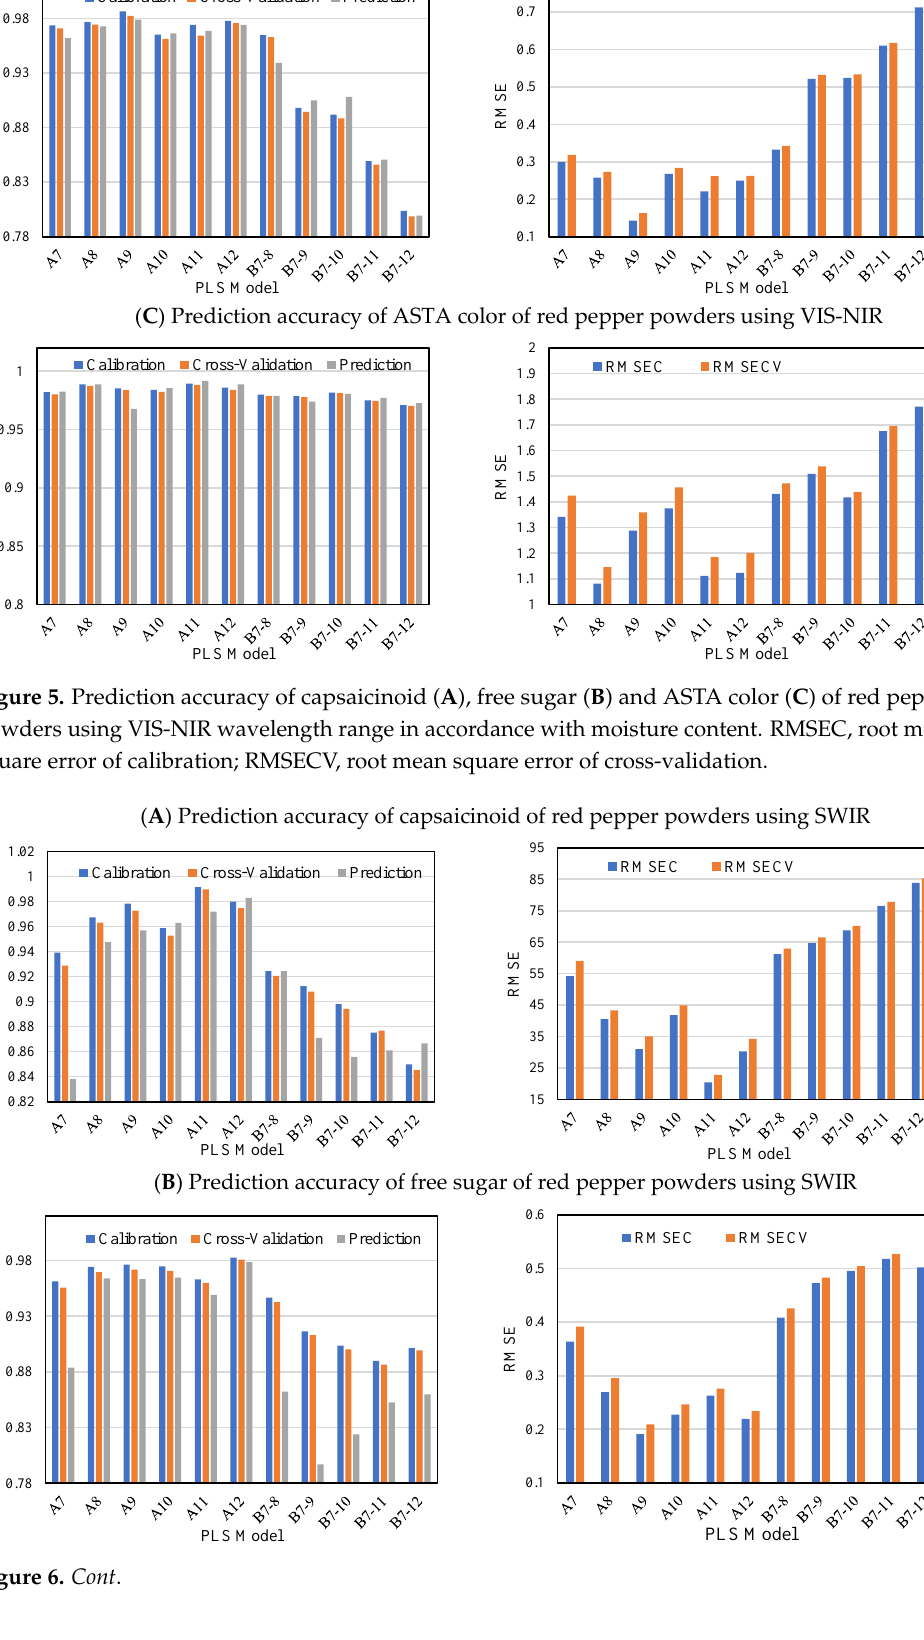
Figure 6. Prediction accuracy of capsaicinoid(A), free sugar(B) and ASTA color(C) of red pepper powders using SWIR wavelength range in accordance with moisture content. RMSEC, root mean square error of calibration; RMSECV, root mean square error of cross-validation. The modeling results for free sugars are as follows. In Figure 5, the prediction Model A with uniform moisture content had an R p2 value of 0.96 or more. However, R p2 decreased in the order of B7-8 (0.94), B7-9 (0.90), B7-10 (0.90), B7-11 (0.85), and B7-12 (0.80) models. In Figure 6, it can be observed that the average R p2 of Model A is 0.951, whereas that of Model B is 0.839, a decrease of about 12%. As shown in Figure 5, the fact that the R p2 value did not decrease sequentially can be interpreted as a slight error according to the resolu- tion of the SWIR system itself and the number of measurement bands. As a result, it means